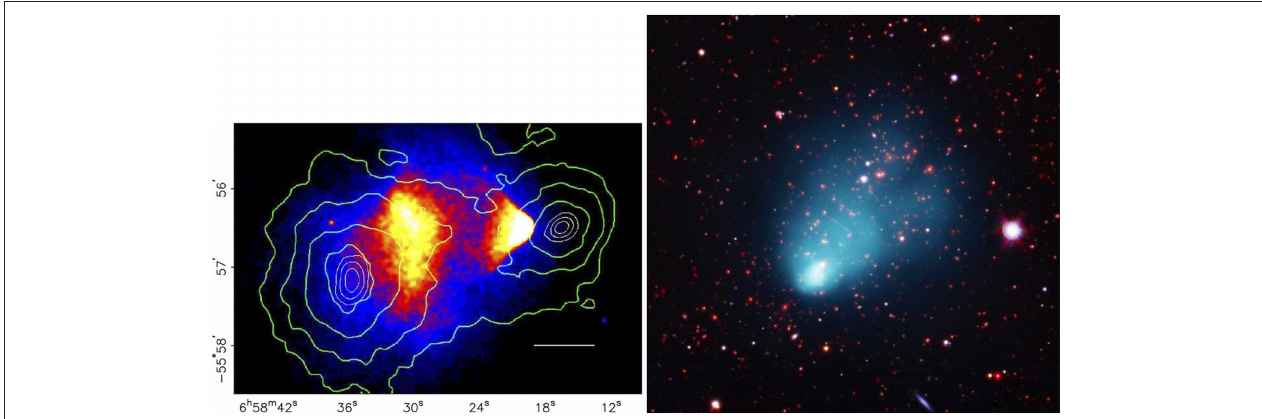
FIGURE 1 | Multi-frequency/component images of merging clusters of galaxies. Left panel: Chandra image of the “Bullet cluster” with green contours showing the projected total mass distribution from gravitational lensing observations (from Clowe et al., 2006). The white contours show the errors in the mass peaks (68.3%, 95.5%, and 99.7% CL). Right panel: A multi-frequency image of “El Gordo”. X-ray emission from NASA’s Chandra X-ray Observatory shown in blue, optical image from the European Southern Observatory’s Very Large Telescope (VLT) and infrared emission from the NASA’s Spitzer Space Telescope in red and orange (from Menanteau et al.,